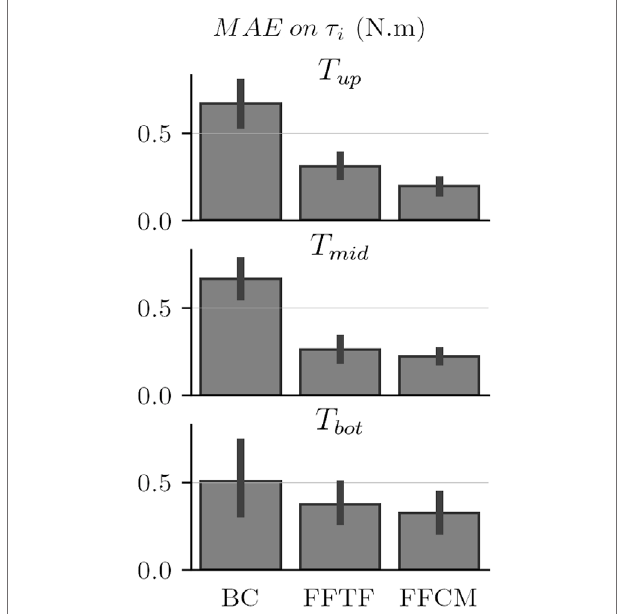
FIGURE 7 | Comparison of the control laws ’ performances under static conditions.